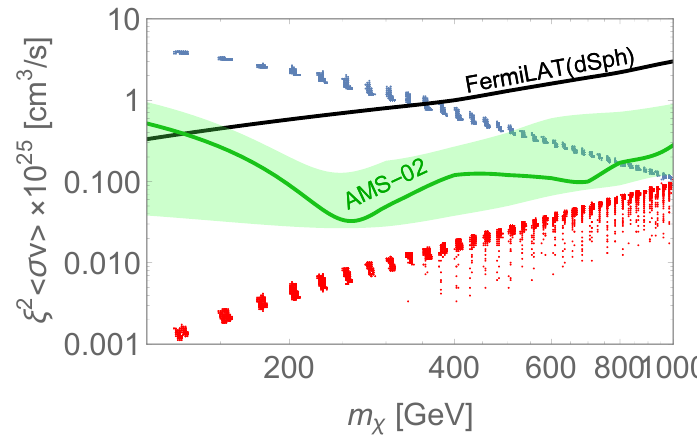
Figure 1 . Exclusion limits and expected values in the NUGM scenario of the dark matter annihi- lation cross section. The blue (red) dots correspond to (cid:24) = 1 ( (cid:24) = (cid:24) th